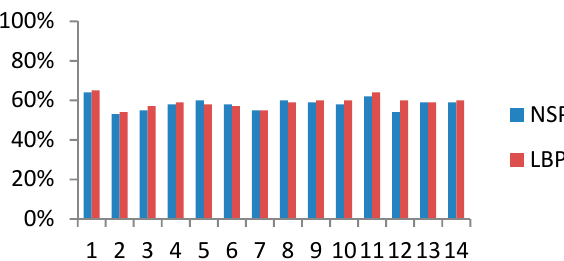
Figure 5. Distribution of pain-related work interference among those experiencing NSP and LBP.